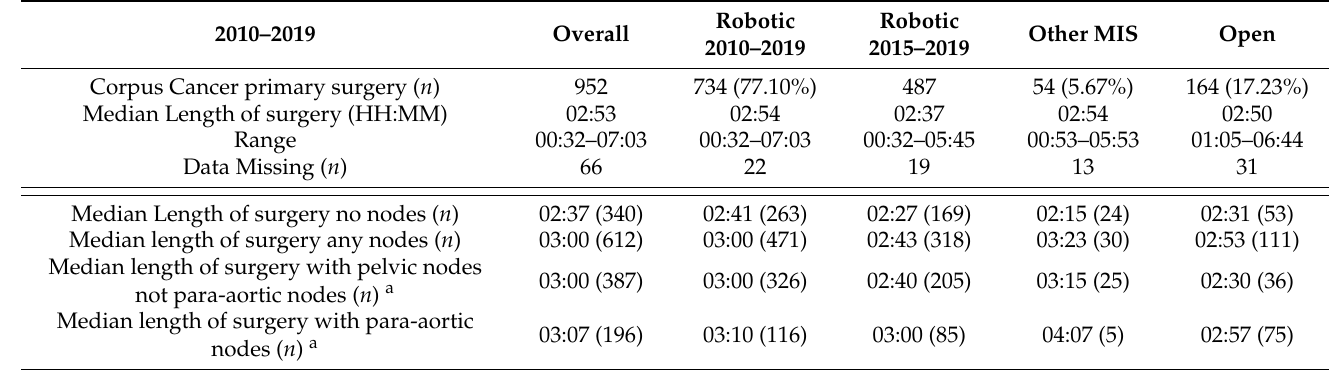
Table 4. Comparison of Length of surgery between Robotic 2010–2019, Robotic2015–2019 (exclud- ing any learning curve) other MIS and open surgery. a as some patients will have pelvic lymph node assessment only and others will also have para-aortic lymph node assessment/sentinel node assessment these numbers are not